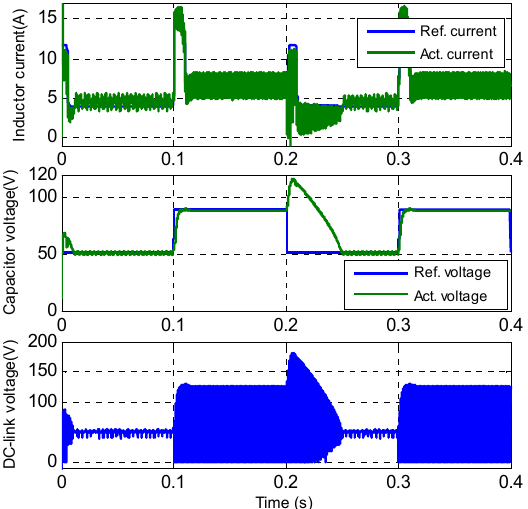
Figure 8. The dynamic performance of the qZSI side without modulated FCS-MPC. From top to bottom: inductor current, capacitor voltage, and DC-link voltage.